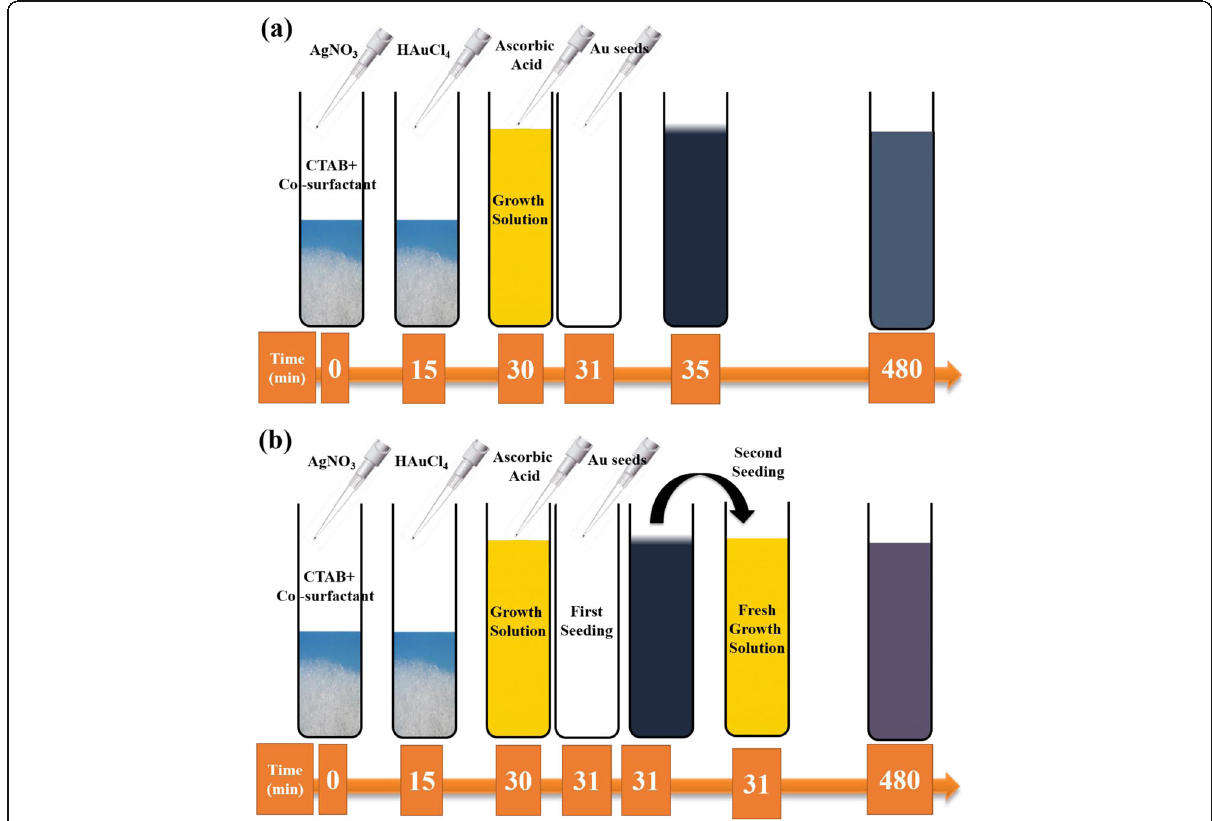
Fig. 1 Schematics of synthesis of Au NSs. a Schematic showing Ag-assisted seeded growth mechanism used for the synthesis of different shapes of Au NSs. b Schematic showing a two-seeded growth mechanism for nano